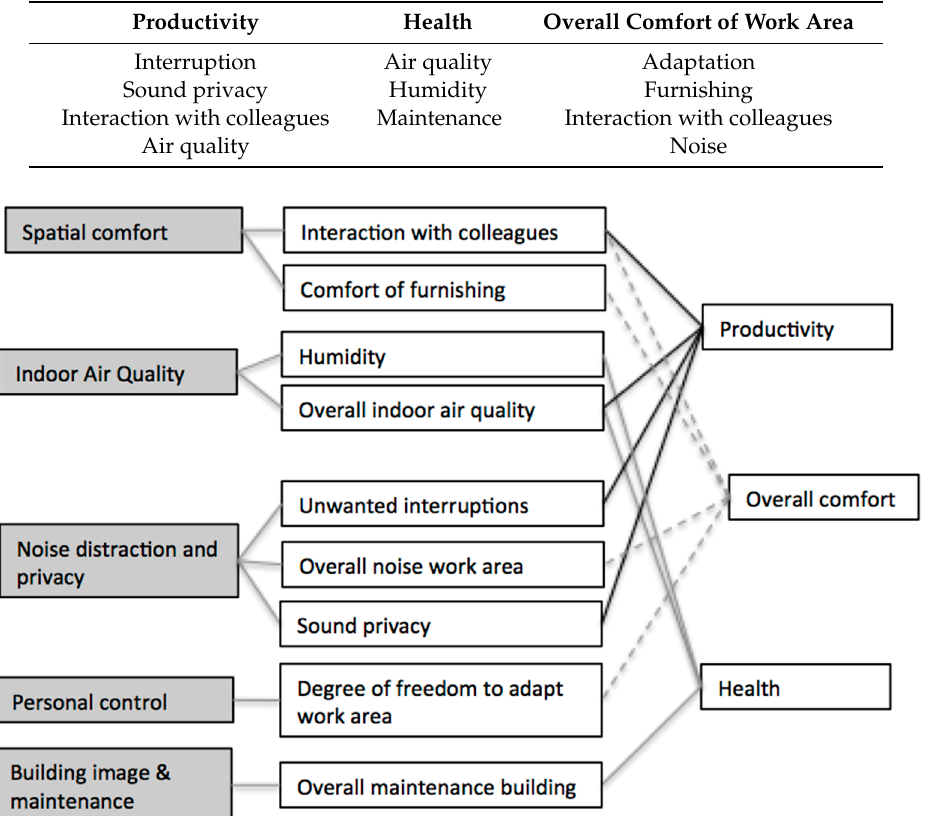
Table 6. Rate of satisfaction and dissatisfaction scores for ( a ) perceived productivity, ( b ) health, and ( c ) overall comfort work area.